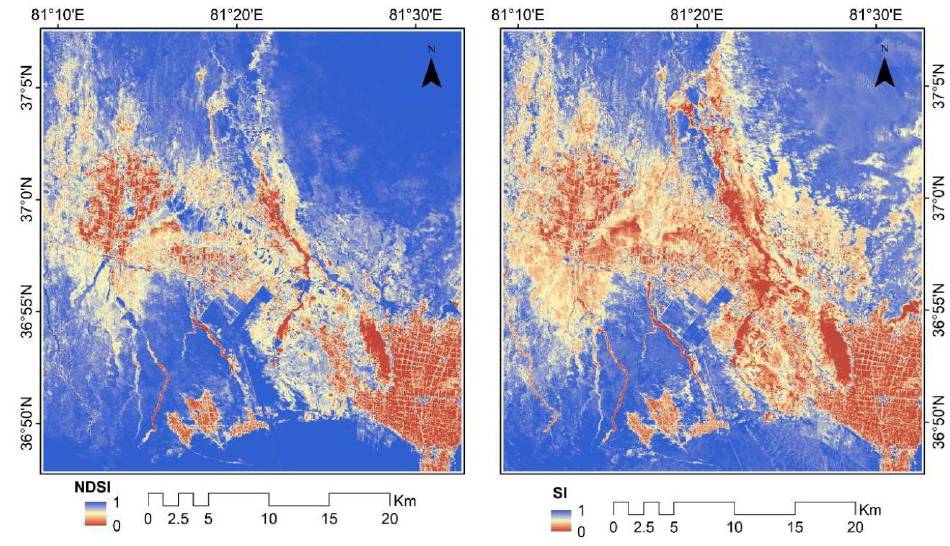
Figure 4. Salt index extraction results.